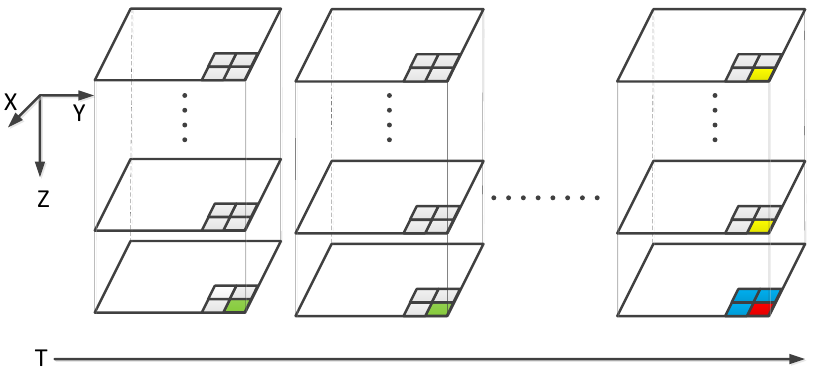
Figure 1. A multitemporal hyperspectral image dataset, where X and Y are the spatial directions, Z is the spectral direction, and T is the temporal